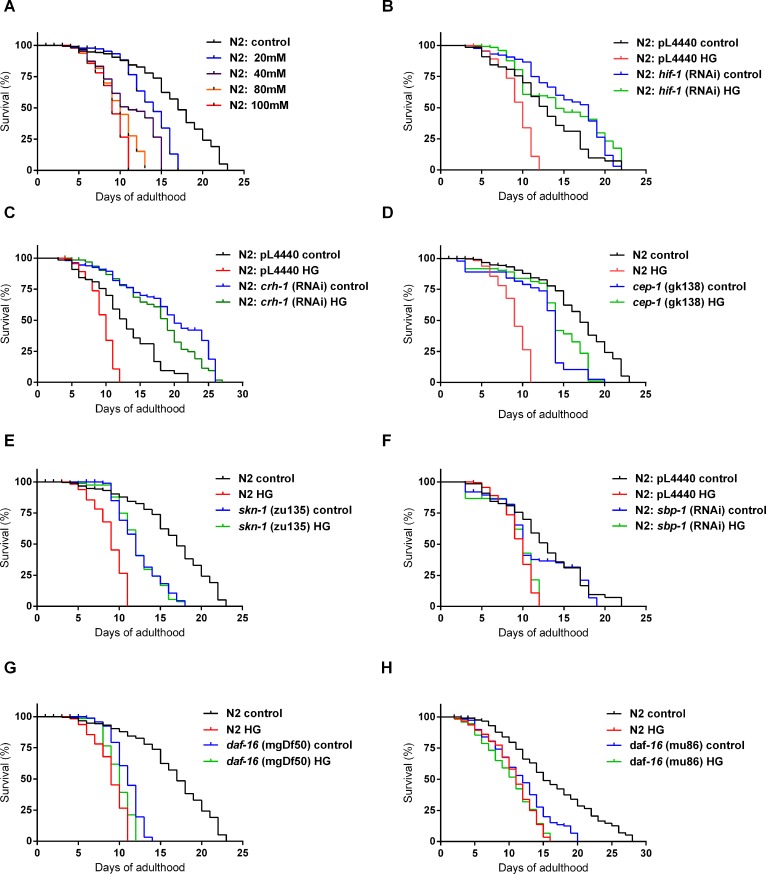
Lifespan of wild-type, mutants or RNAi knock-downs of stress-responsive transcriptional regulators worms upon feeding a HGD.(A) Lifespan curves for adult worms that were exposed from L1 larval stage to the end of their life cycle to 20, 40, 80 or 100 mM glucose (n = 110). (B-H) Lifespan curves for mutants or RNAi knock-downs of adult worms that were exposed from L1 larval stage to the end of their life cycle to 100 mM glucose and compared to controls (n = 110 worms per condition), (B) hif-1(RNAi); (C) crh-1(RNAi); (D) cep-1(gk138); (E) skn-1(zu135); (F) sbp-1(RNAi); (G) daf-16(mgDf50); (H) daf-16(mu86). For RNAi experiments, bacteria containing empty vector pL4400 was used as a control. Differences between groups were calculated using the log-rank test. See Supplemental S2 Table for statistical analysis of lifespan data shown in this figure.